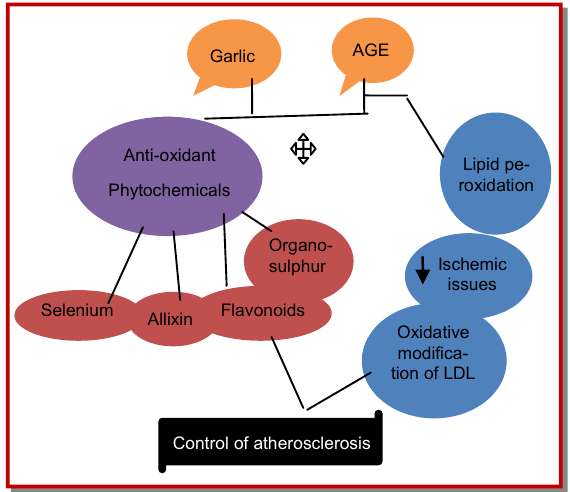
Figure 2: Garlic and AGE play role in the production of anti- oxidant phytochemicals like selenium, allixin, flavonoids and organosulphur. AGE is also responsible to inhibit lipid peroxidation, oxidative modification of LDL and decreasing of ischemic issues